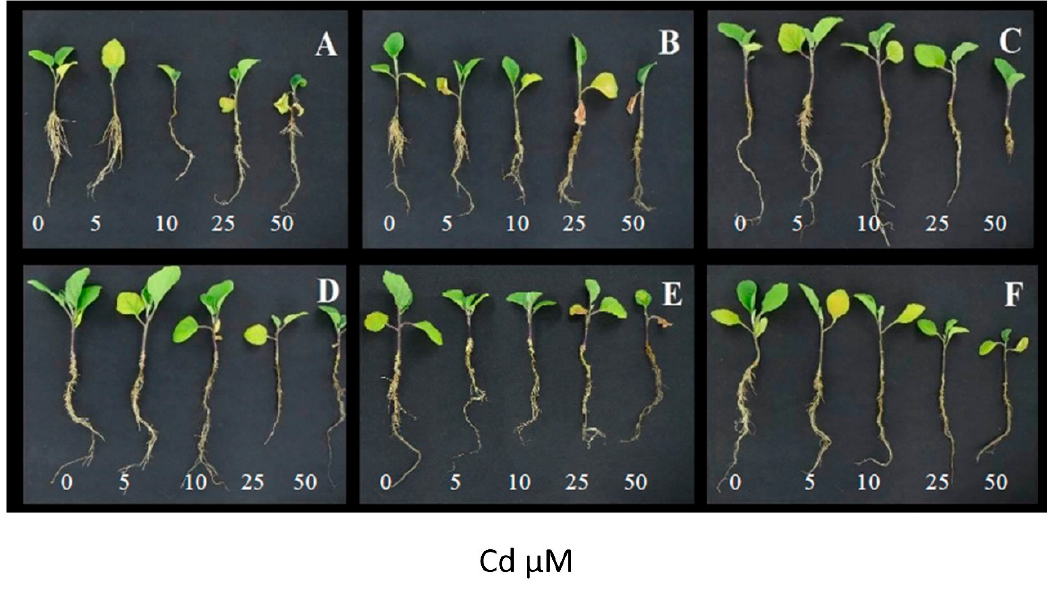
Figure 2. Effect of Cd on eggplant morphology in hydroponic culture. Each panel includes five plantlets treated with different Cd concentrations. ( A ) Bellezza Nera (BN); ( B ) Cima Viola (CV); ( C ) Hybrid F1 Purple Queen (PQ); ( D ) Rotonda Bianca Sfumata di Rosa (RB); ( E ) Violetta di Firenze (VF); ( F ) Violetta Lunga (VL).